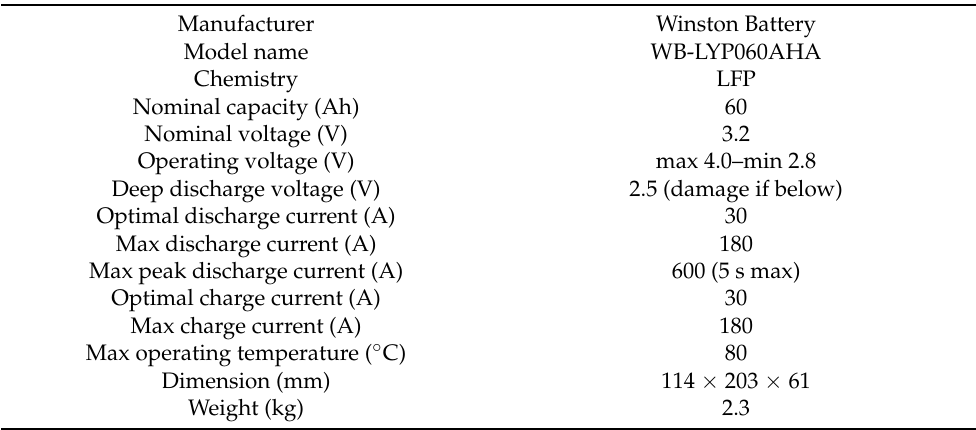
Table 1. LFP lithium cell characteristics.